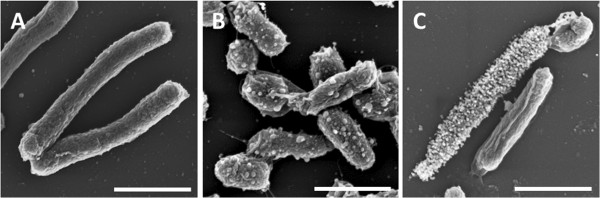
Time resolved mineralization of calcium carbonate in medium with and without Zn2+. The initial stages of the mineral formation show no differences between the cultures in media with and without Zn2+ and various Ca-acetate concentrations. A) After 24 h bacteria show no sign of accumulation of inorganic particles on the cell surface. B) and C) In the further course of the cultivation (7 days), bacteria accumulate globular inorganic particles in different amounts on the cell surface. Bars represent 1 μm.